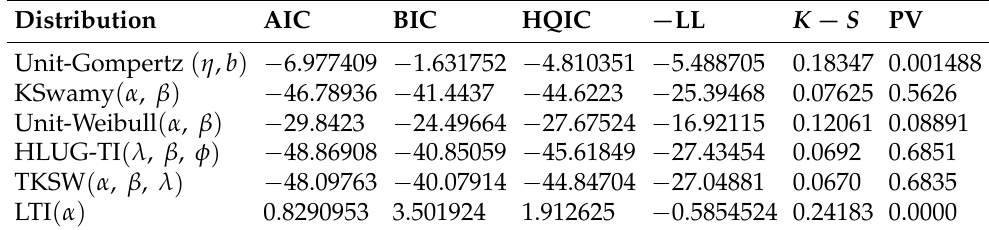
Table 5. Values of the considered goodness-of-fit measures for Data